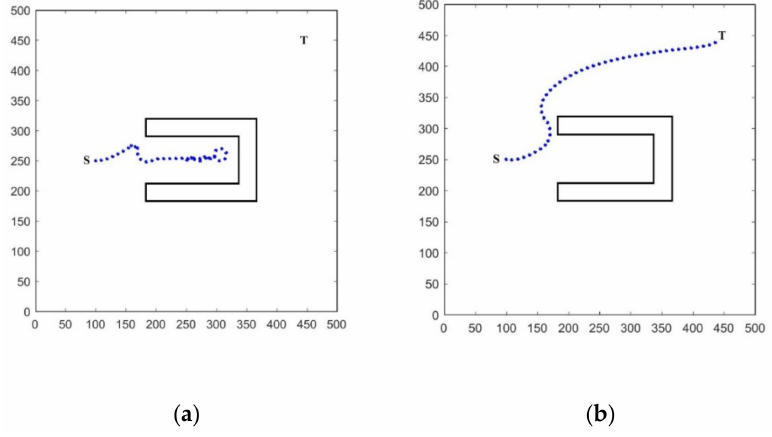
Figure 6. Environment IV. The figures contain the simulation paths of the following algorithms: ( a ) APF and ( b ) DA-APF. Table 4. Performance results for Environment IV (mean values from 50 runs for all algorithms). Algorithms Time Path Length Success Rate/% APF 4.15 * 492 * DA-APF